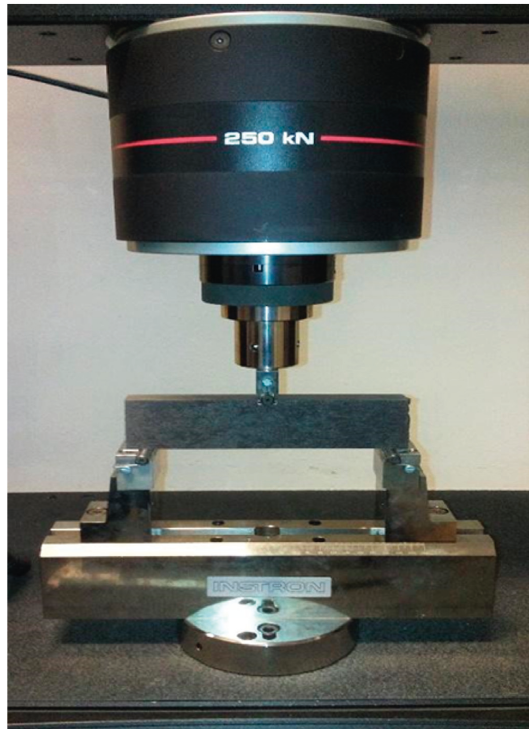
Figure 2: Three-point flexural strength test of a Formulation 1 sample.